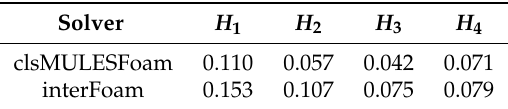
Table 5. -norm of the errors for the measured L 2